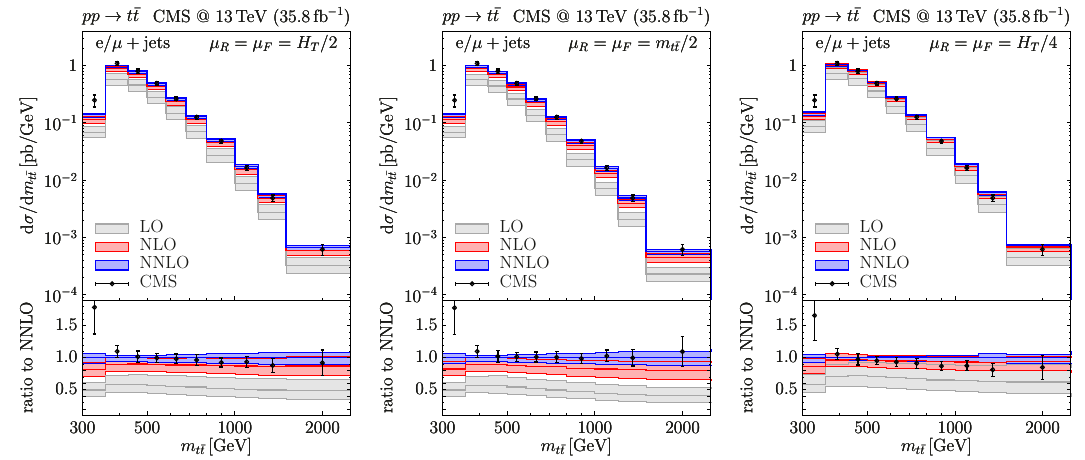
Figure 4 . Single-di(cid:11)erential cross sections as a function of m NNLO results for central scales equal to H T = 2 (left), m t (cid:22) t = 2 (central) and H T = 4 (right).